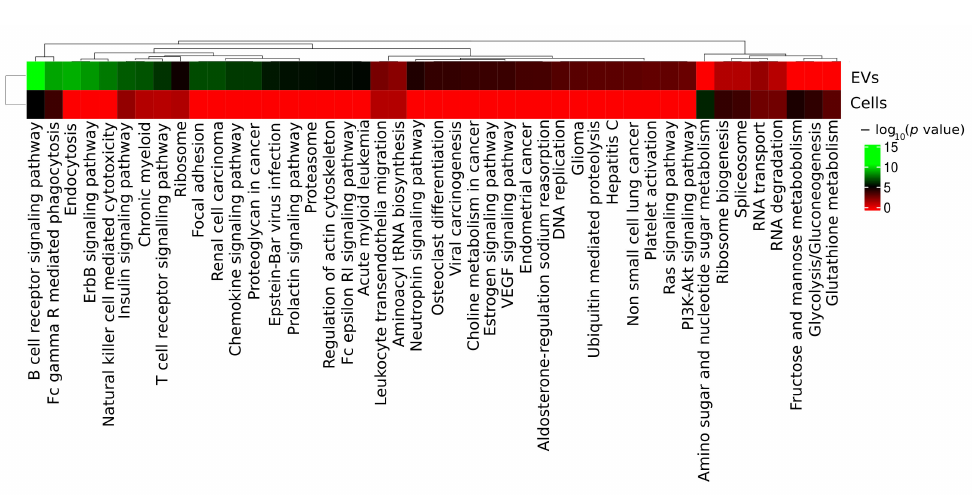
Figure 5. Overview of KEGG pathways enriched among significantly differential regulated proteins in DLBCL EV proteins and whole-cellular proteome. KEGG pathways colored in green reflect the high abundance of proteins in each category as opposing to pathways colored in red measured by − log 10 ( p